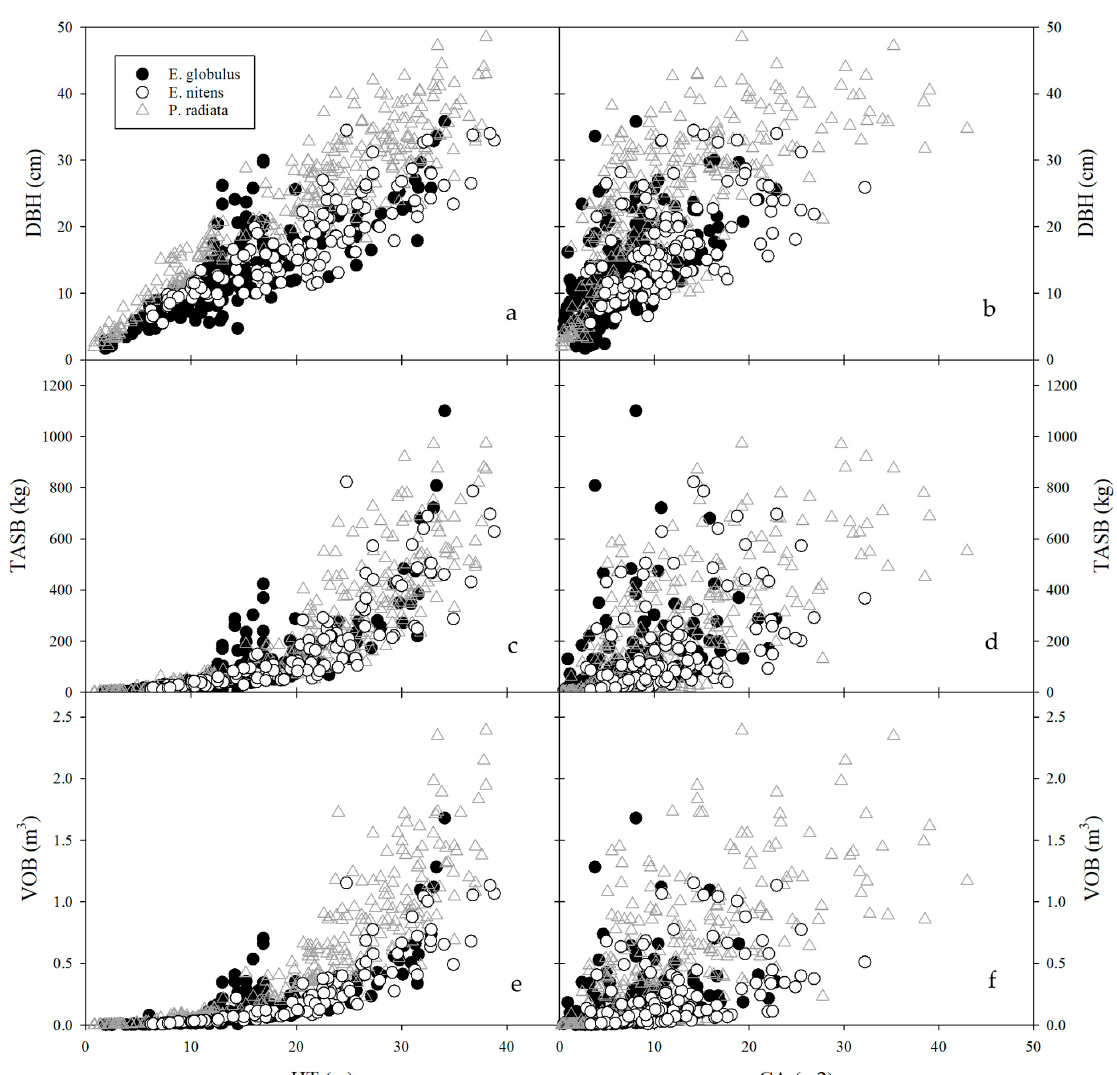
Figure 2. Relationships between total tree height (HT, m) and ground projected crown area (CA, m 2 ) with stem outside bark diameter at 1.3 m height (DBH, cm) ( a , b ), total above-stump biomass (TASB, kg) ( c , d ), and stem volume over bark (VOB, m 3 ) ( e , f ) for E. globulus (filled circle), E. nitens (open circle), and P. radiata (grey open triangle) trees growing in central Chile.